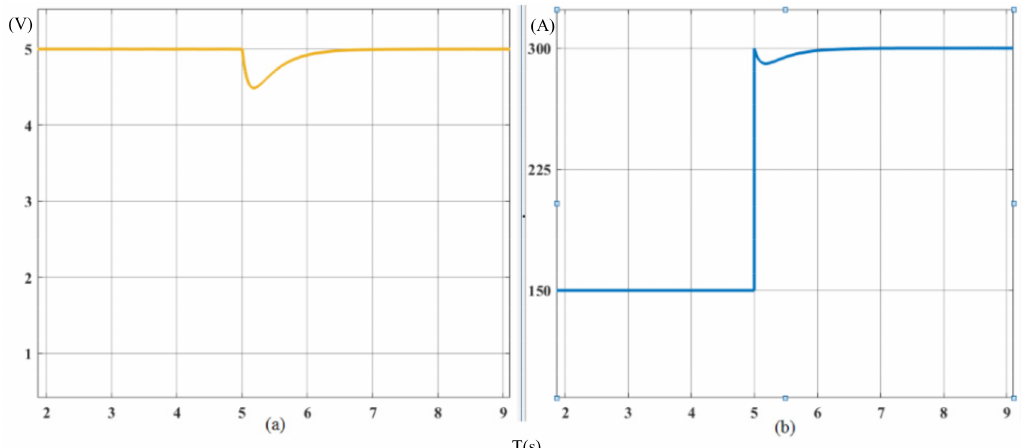
Figure 14. DC output waveforms controlled by the direct power control method when the load suddenly increases: ( a ) voltage waveform; ( b ) current